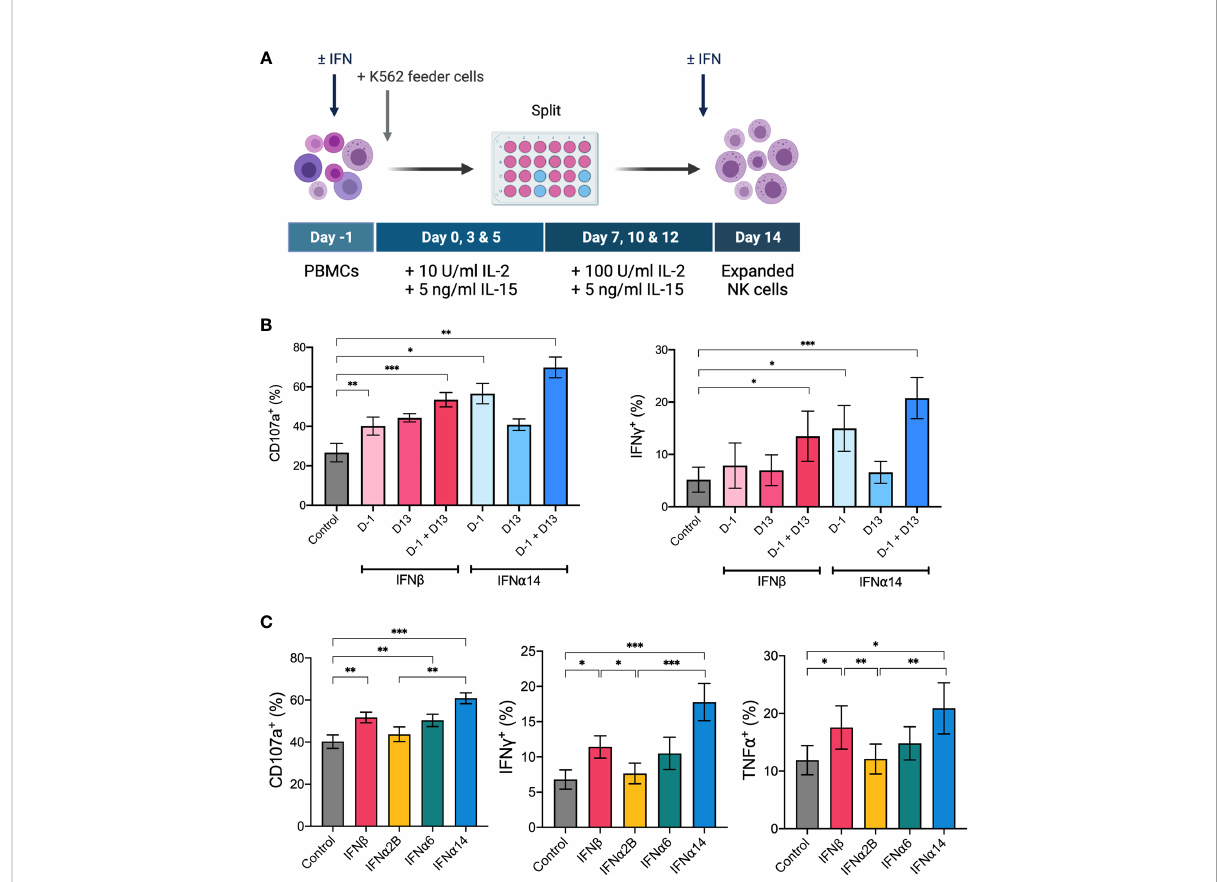
FIGURE 5 IFN a 14 and IFN b stimulation enhances NK cell activity in vitro following ex vivo expansion PBMCs were expanded ex vivo for 14 days either with or without IFN-I stimulation. (A) Schematic of NK cell expansion strategy. On day -1 PBMCs were left unstimulated or stimulated with 100 IU mL -1 IFN-I overnight. Following overnight activation, NK cells were expanded for 13 days with IL-15, IL-2, and irradiated K562 feeder cells. On day 13 NK cells were either left unstimulated or stimulated with 100 IU mL -1 IFN-I overnight. (B) Expanded NK cells that received either no IFN-I activation (control), one dose of IFN-I (D-1 or D13), or two doses of IFN-I (D-1 + D13) were collected on day 14, washed, and assessed for effector function following stimulation with K562 cells for 5 hours at a 2:1 E:T ratio. Summary plots show the mean + SEM percentage of CD56 + CD3 neg NK cells expressing CD107a or producing IFN g or TNF a . n = 5, 2 independent experiments. Data were compared to the control condition using a paired Student ’ s t test. * p < 0.05, ** p < 0.01, *** p < 0.001. (C) PBMCs from 16 healthy donors were expanded either without IFN-I stimulation (control) or with IFN-I stimulation on day -1 and day 13. Expanded NK cells were collected on day 14, washed, and assessed for effector function following stimulation with K562 cells at a 2:1 E:T for 5 hours. Summary data show mean ± SEM percentage of CD56 + CD3 neg NK cells expressing CD107a or producing IFN g or TNF a . Data were compared using a paired Student ’ s t test. * p < 0.05, ** p < 0.01, *** p <